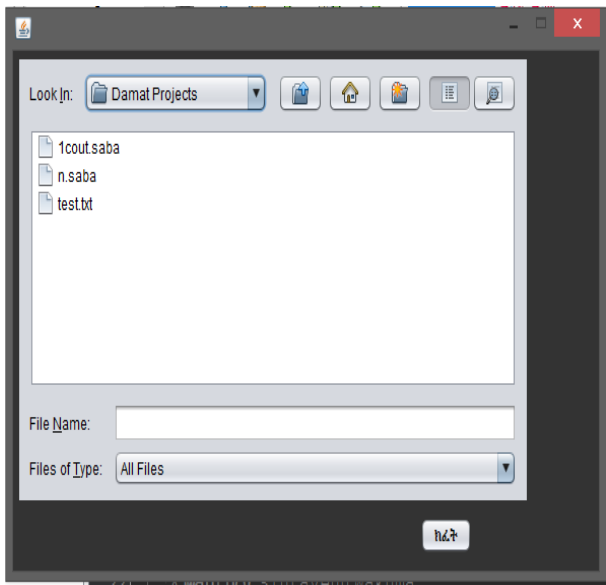
• Run project file sample code: this example shows simple input and output by a variable declaration that are shown below in figure 5.